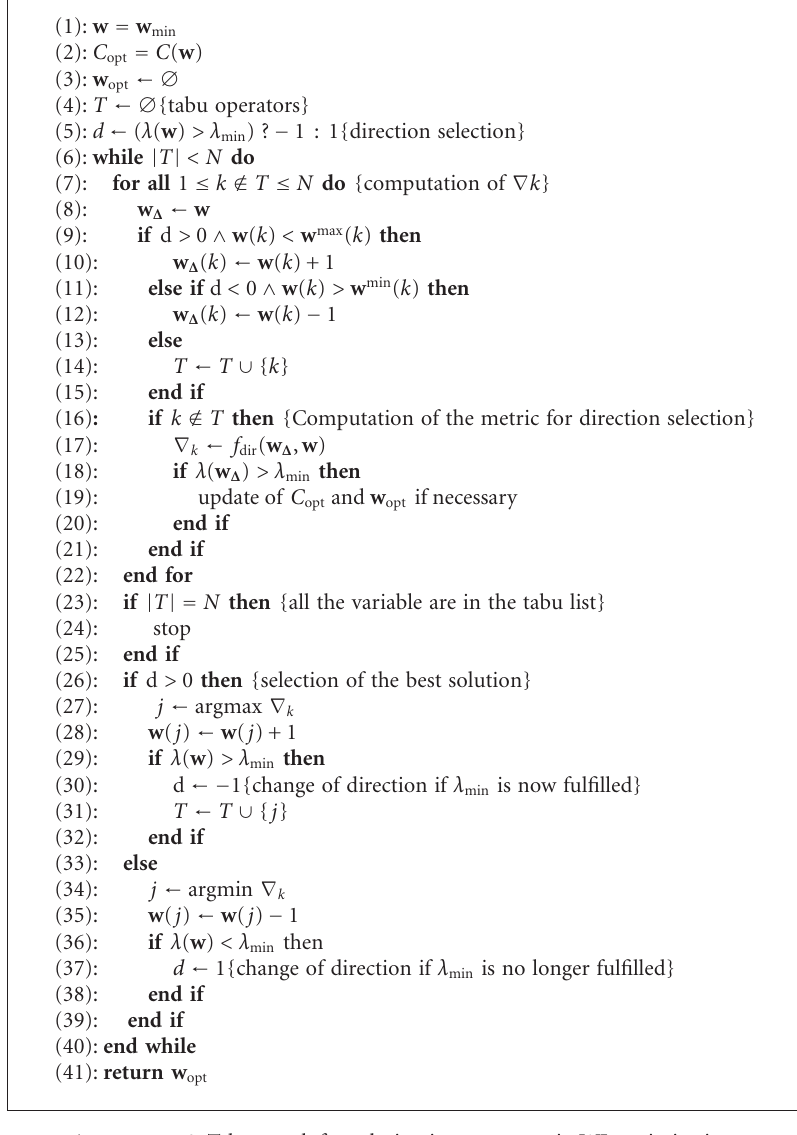
Algorithm 3: Tabu search for solution improvement in WL optimization.